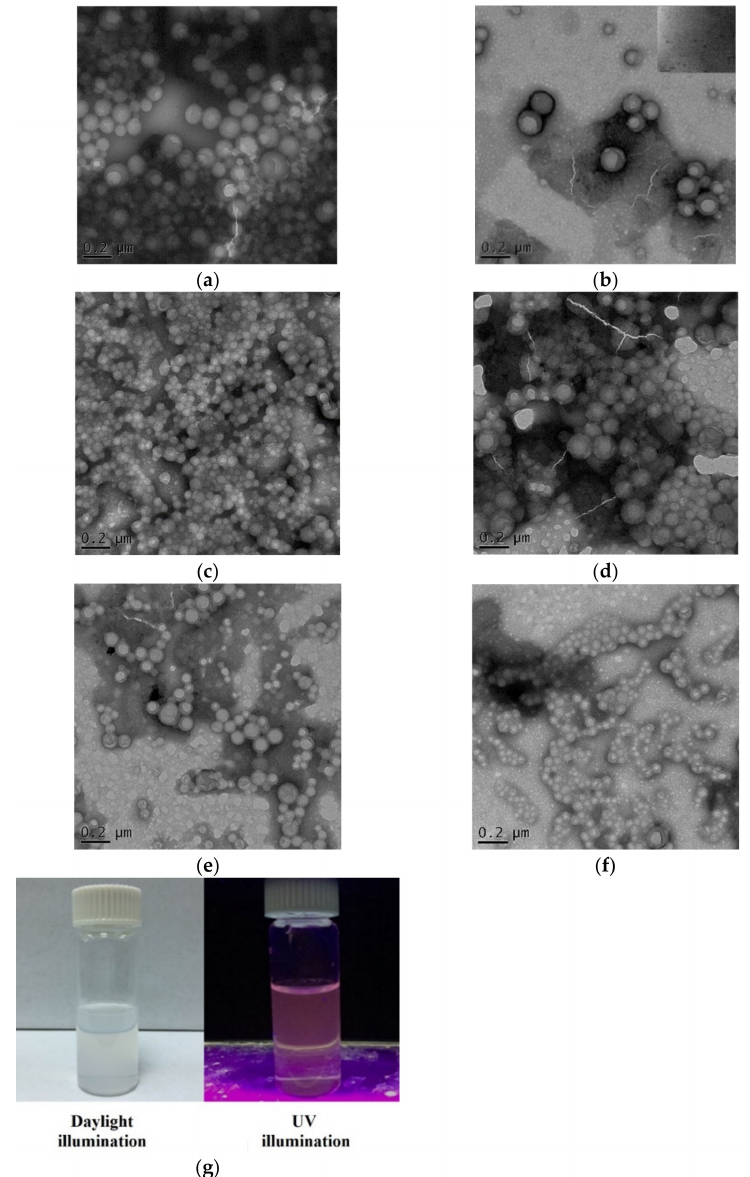
Figure 3. TEM images of d Asp 3 -PEG-PLGA (APP) NPs ( a ), GNC-PLGA/ d Asp 3 -PEG-PLGA (GNC-PLGA/APP) NPs ( b ), PLGA-PEG-OMe (PP) NPs ( c ), GNC-PLGA/PLGA-PEG-OMe (GNC- PLGA/PP) NPs ( d ), simvastatin/ d Asp 3 -PEG-PLGA (SIM/APP) NPs ( e ), and simvastatin/PLGA- PEG-OMe (SIM/PP) NPs ( f ), prepared using the solvent displacement method. Photos of the fluorescence emission of GNC-PLGA/APP NPs (weight ratio ~1/2) were observed under ultraviolet light (UV) and daylight illumination ( g